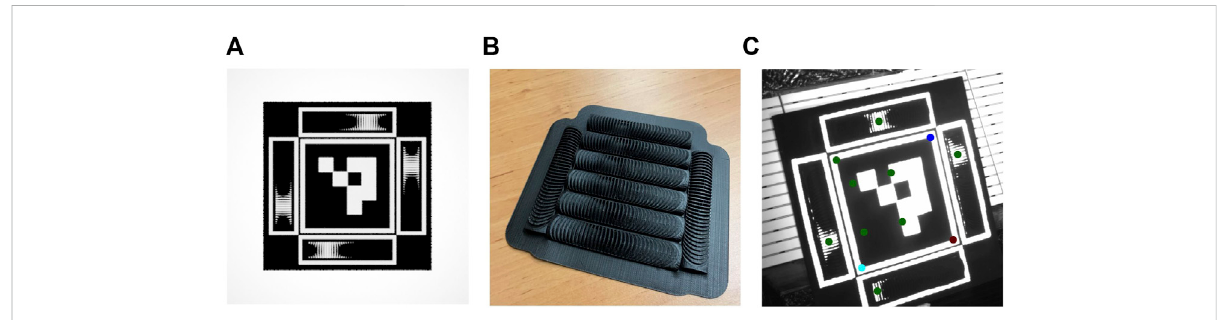
FIGURE 6 End-to-end implementation of the proposed encoding element in a fi ducial marker. (A) Render of ArUco with additional proposed encoding elements. (B) 3D printed encoding elements (C) Output of feature extraction. Note that the bottom blob fails our veri fi cation step due to close proximity to the edge of the marker, thus both virtual points on the left are not passed to the pose estimation block.